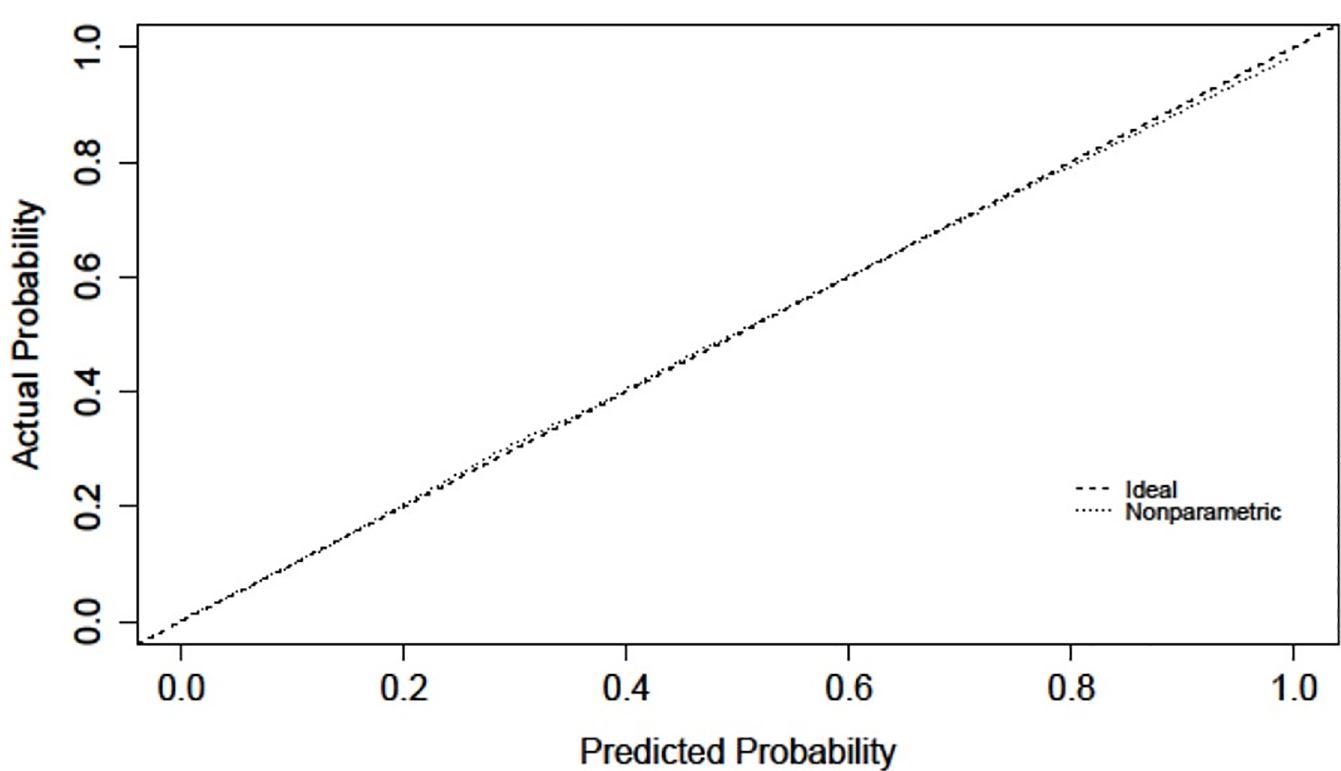
Fig 2. Calibration plot demonstrating the relationship between predicted and observed risk among